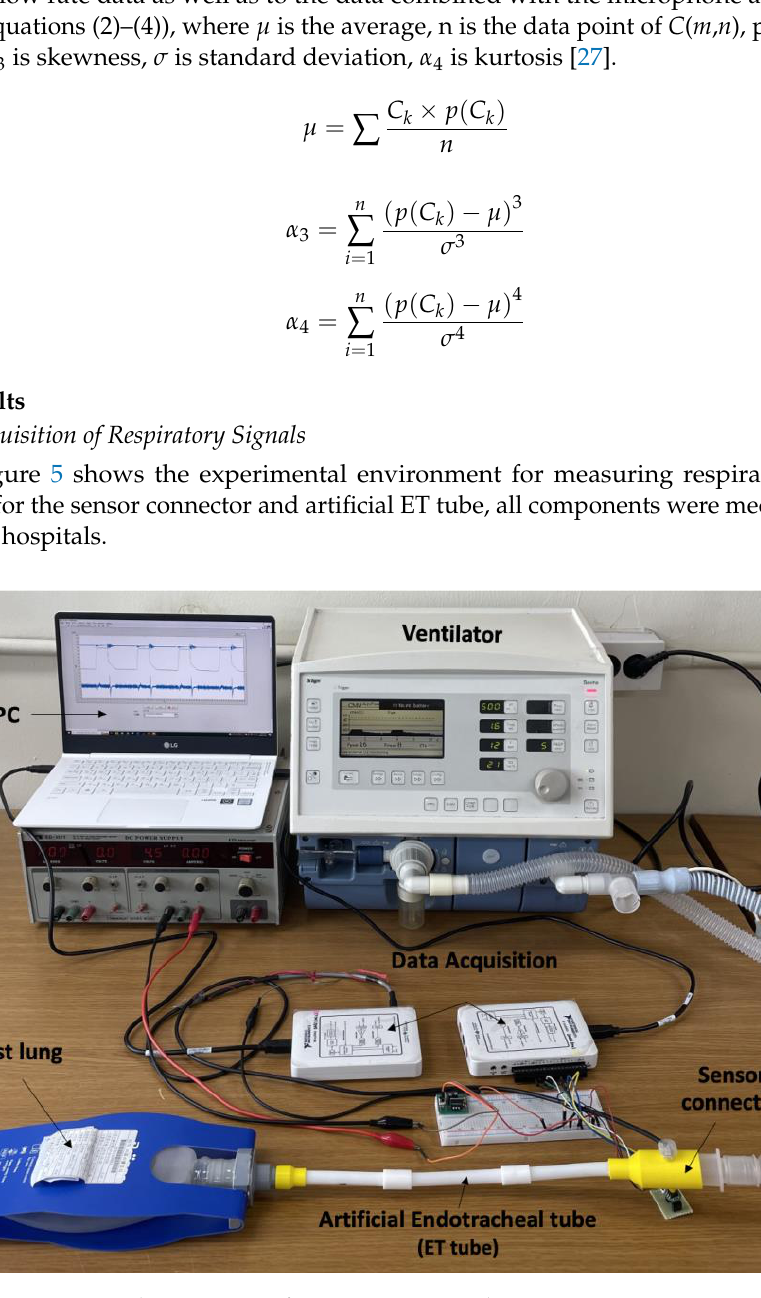
Figure 5. Experimental environment for respiratory signal measurement.